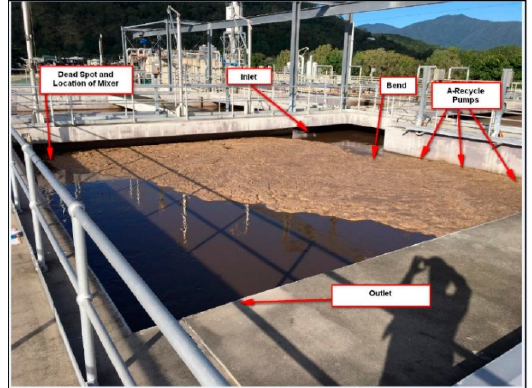
Figure 1. NWWTP Anoxic Zone 1.